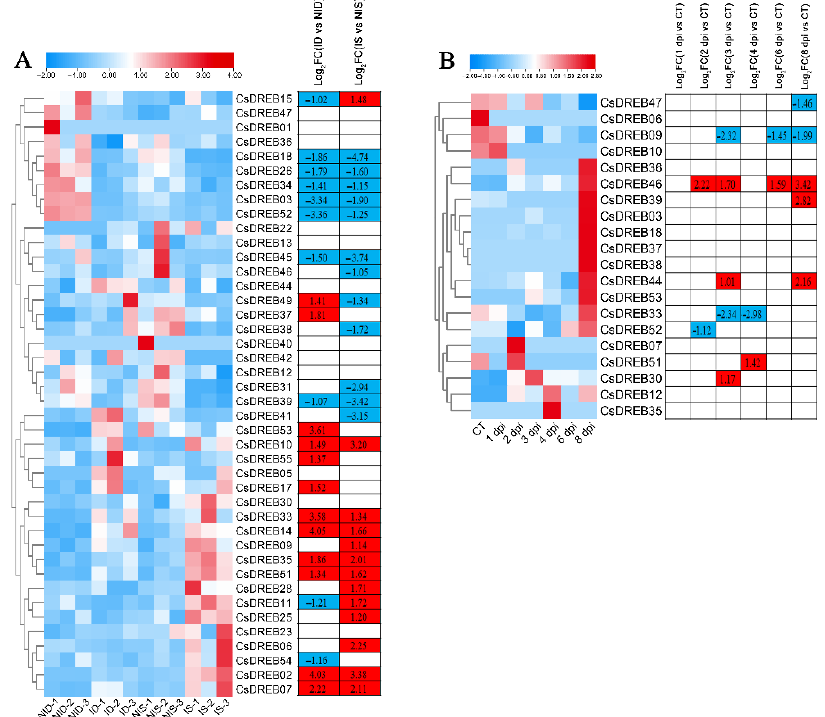
Figure 10. Expression analysis of CsDREBs under biotic stresses: The transcriptional levels of CsDREB genes after infection with powdery mildew (PM) for 48 h ( A ) and with downy mildew (DM) for 1–8 days post-inoculation ( B ) are shown on the heatmaps. A range of −3.00 to 3.00 was artificially set with the color scale limits according to the normalized values. The color scale shows increasing expression levels from blue to red. ID, PM-inoculated susceptible cucumber line D8 leaves; NID, non-inoculated D8 leaves; IS, PM-inoculated resistant cucumber line SSL508–28 leaves; NIS, non-inoculated SSL508–28 leaves; CT, without inoculation; DPI, days post inoculation; FC, fold-change.